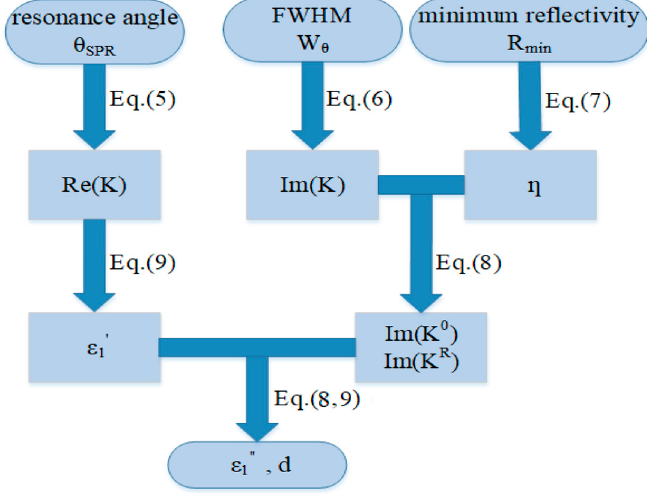
Figure 2. Flow chart for the dielectric constant calculation. Full width at half maximum